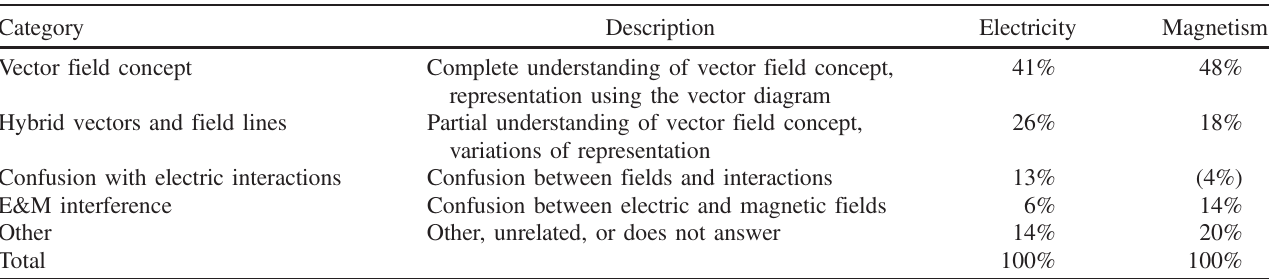
TABLE I. We compare the categories of understanding the field concept that emerged from students ’ drawings and explanations in the electric and magnetic contexts. In the magnetic context, the category confusion with electric interactions emerged combined with the E&M interference; therefore, we included 4% of students in the